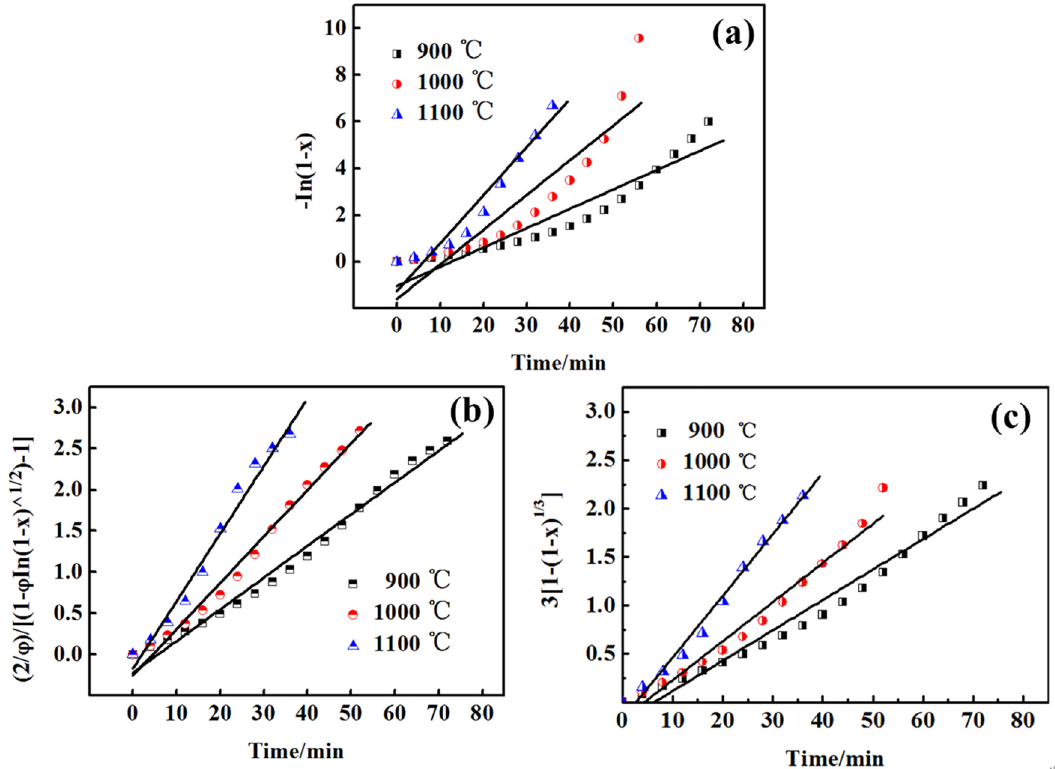
Figure 10: Fitting curve of carbon conversion using di ff erent kinetic models: ( a ) HM, ( b ) RPM, and ( c )